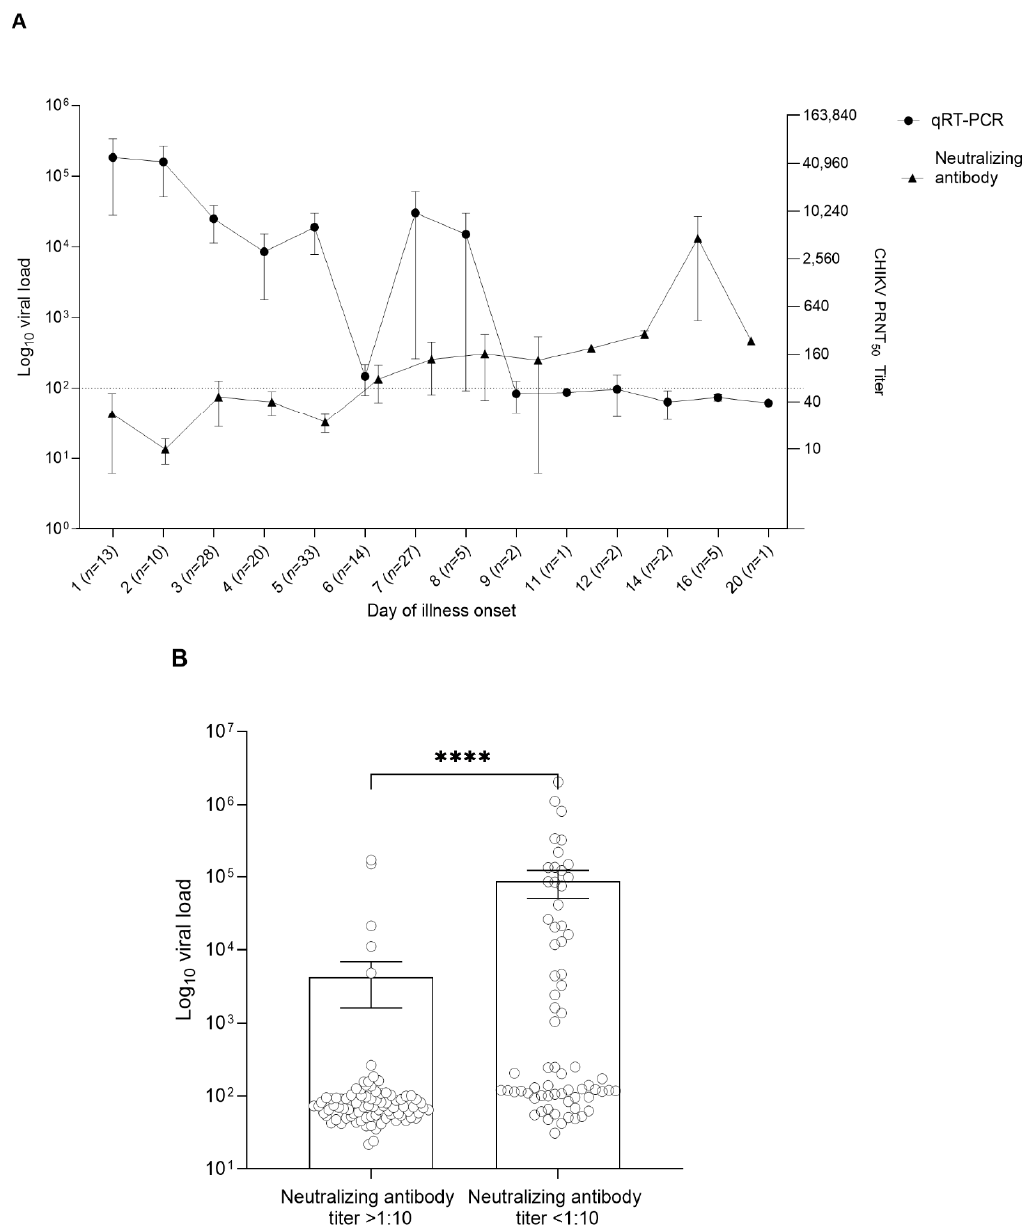
Figure 2. Immune response in patient samples with confirmed CHIKV infection ( n = 159). ( A ) Dy- namic of the CHIKV viral load and neutralizing antibodies on the day of illness onset. X -axis shows the day of illness with the number of patients. ( B ) Comparison of CHIKV viral load between the neutralizing antibody titer > 1:10 and neutralizing titer < 1:10. Error bars showing the standard mean error of the sample means. p -values are calculated using Mann − Whitney test. **** p < 0.0001.